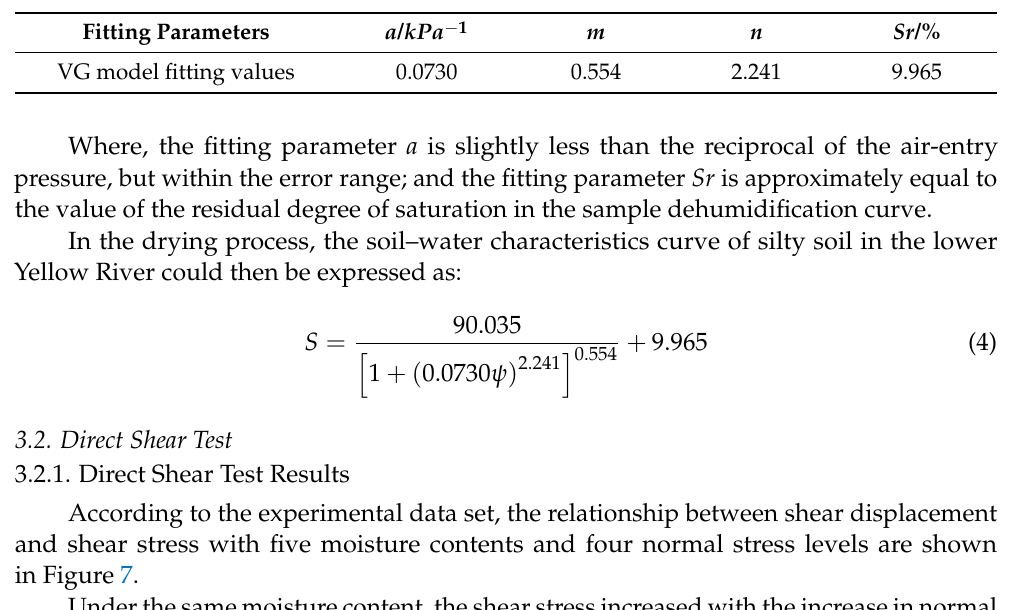
Figure 6. Fitting diagram of SWCC. Table 2. Fitting parameter value